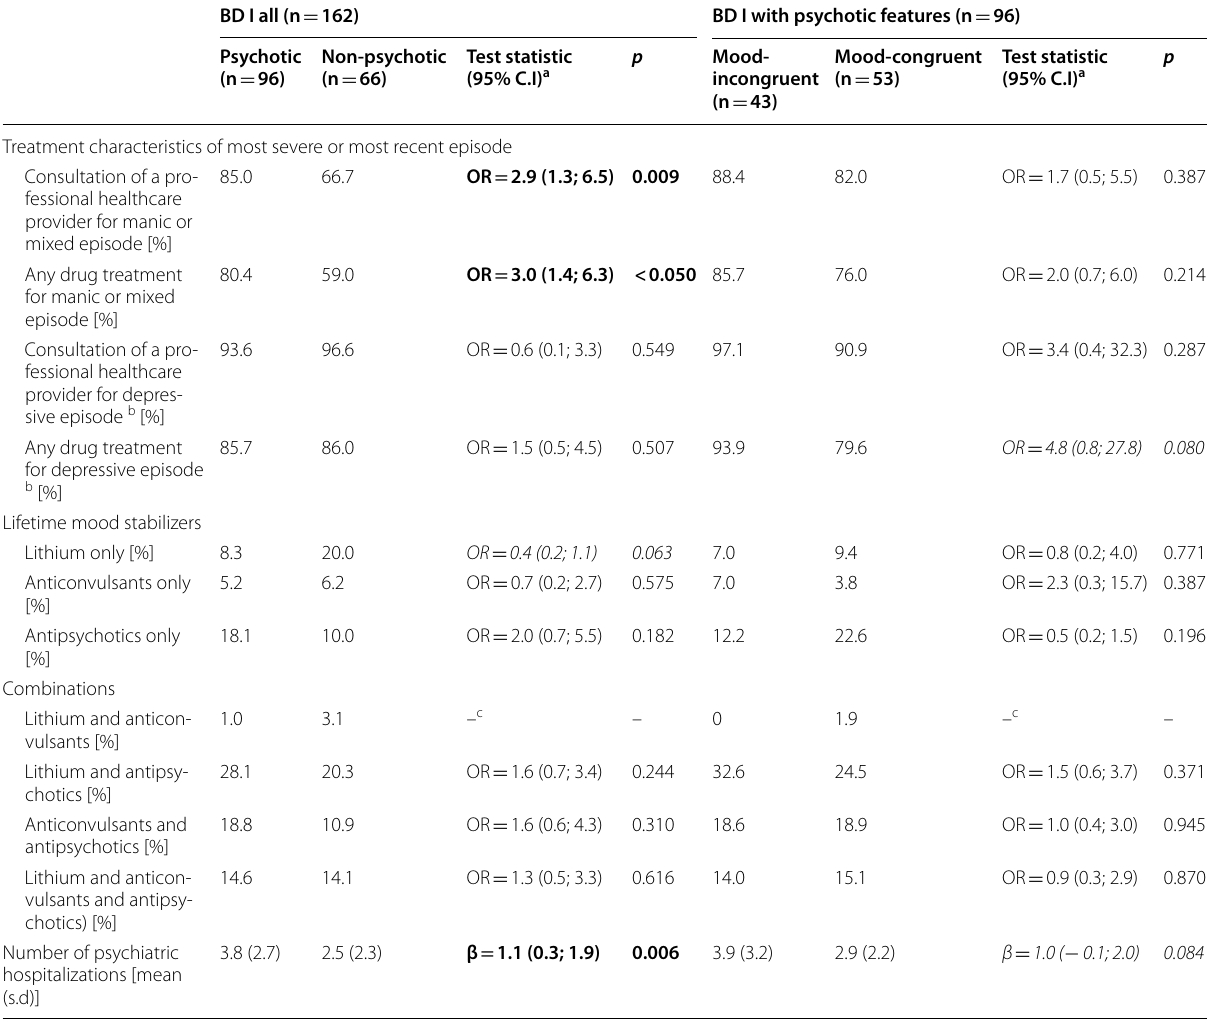
Table 4 Treatment characteristics by lifetime psychotic feature